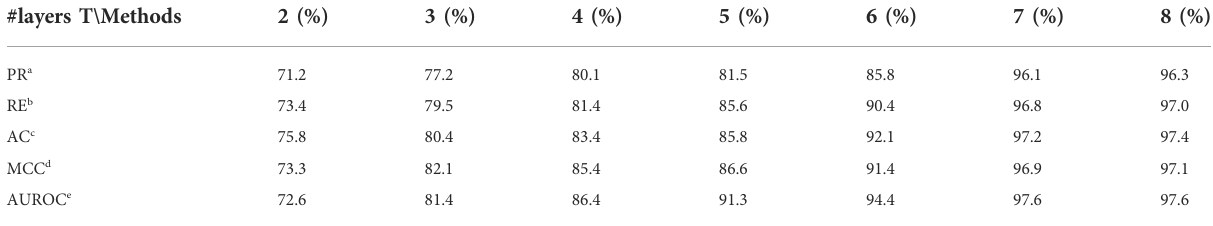
TABLE 3 Results of different AGG and MES functions with multiple measurements. #layers